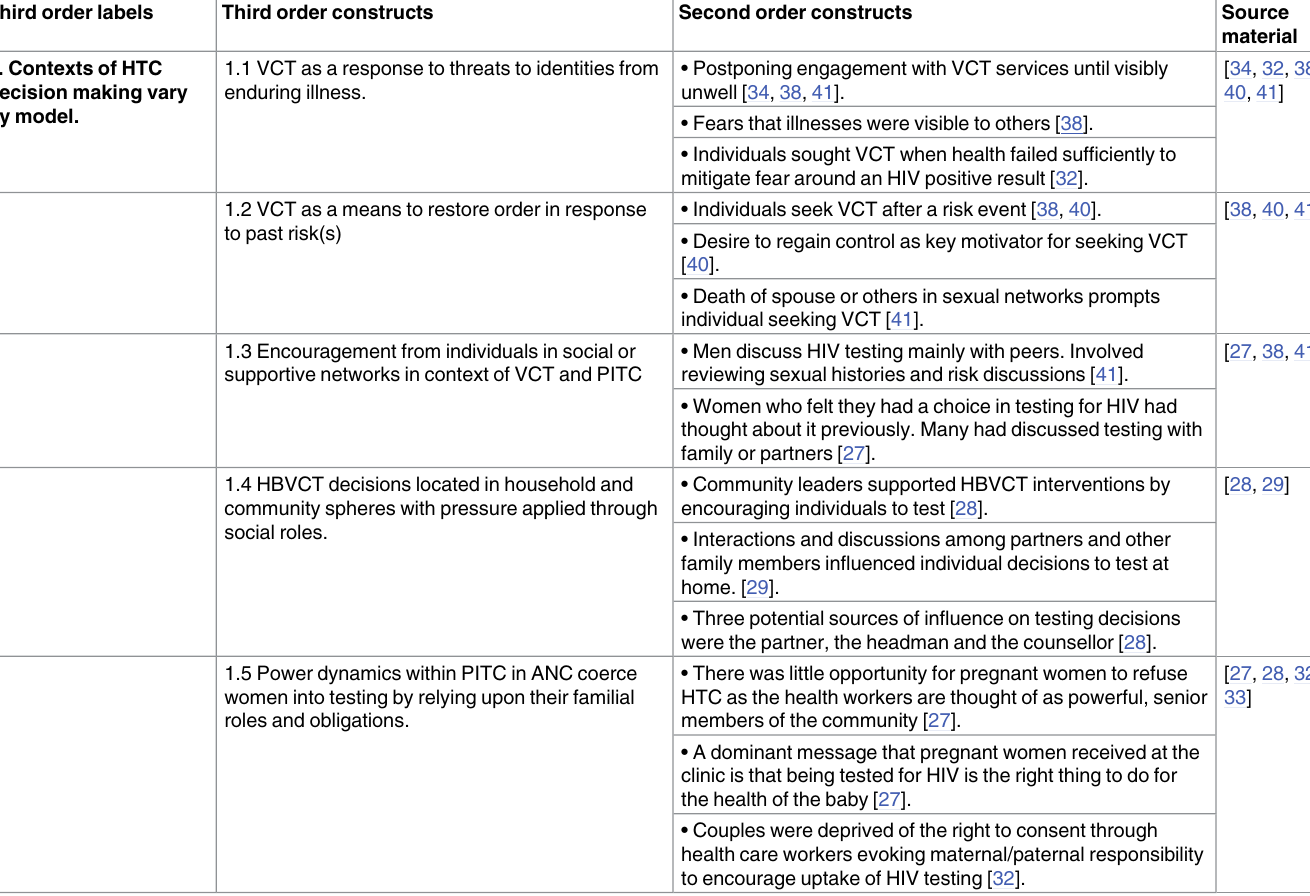
Table 4. Context of HTC